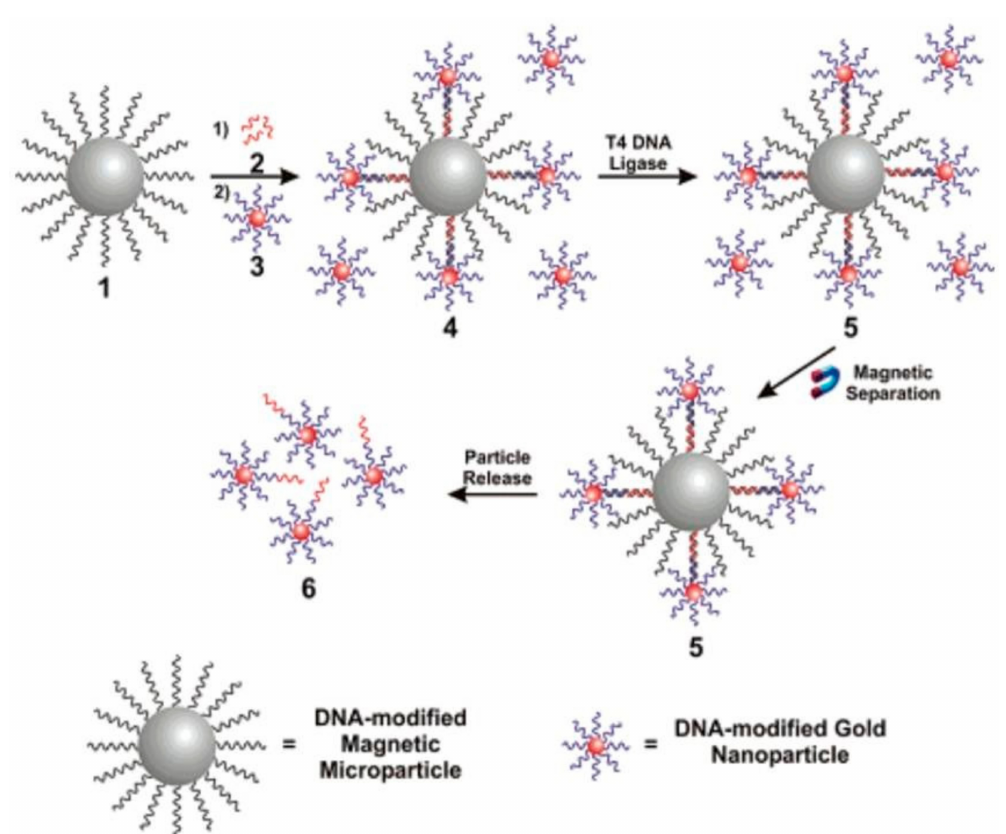
Figure 47. Functionalization of Au NPs with asymmetric oligonucleotides. Reproduced with permission from reference [339], Copyright 2005, ACS.